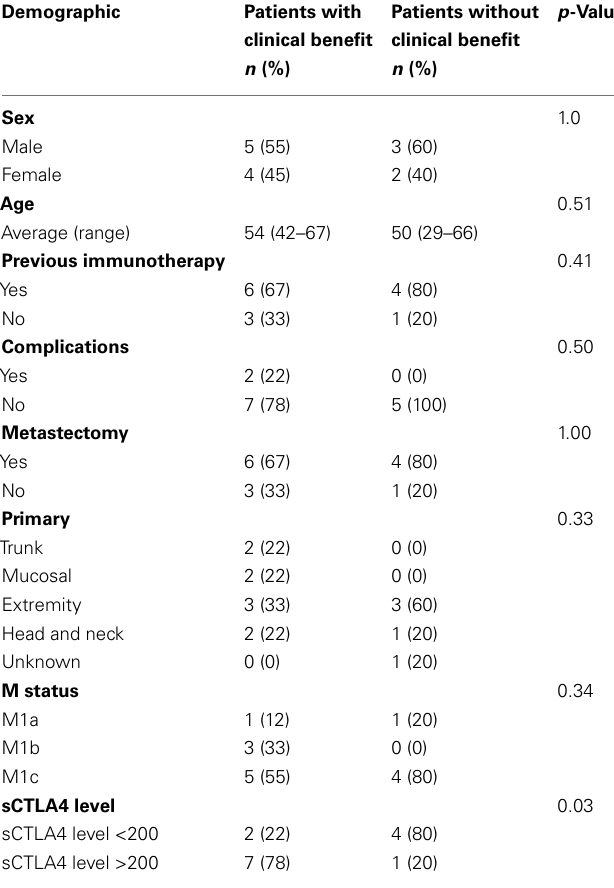
Table 1 | Demographics of ipilimumab-treated melanoma patients with clinical benefit vs. patients without clinical benefit